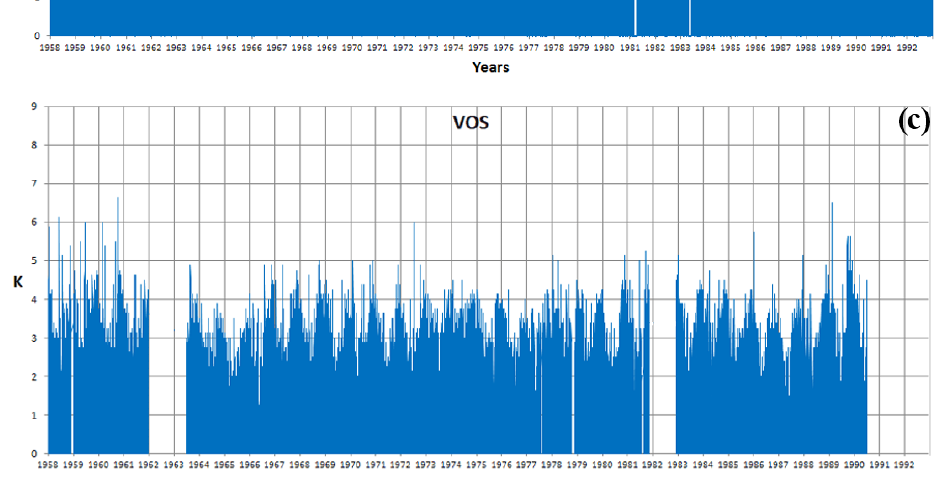
Figure 8. K index daily mean values for the period 1958–1992 for three observatories: (a) Heiss Island (HIS); (b) Irkutsk (IRT); (c) Vostok